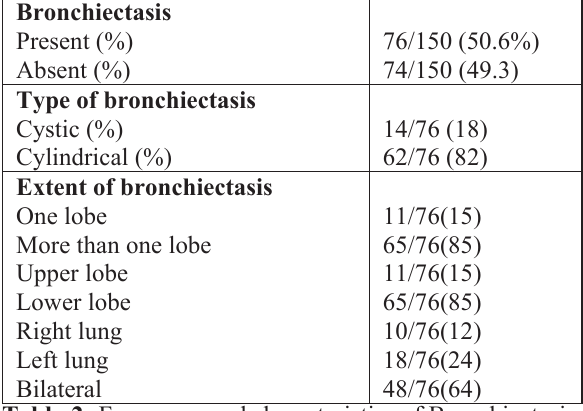
Table-2: Frequency and characteristics of Bronchiectasis (n=150) Parameter